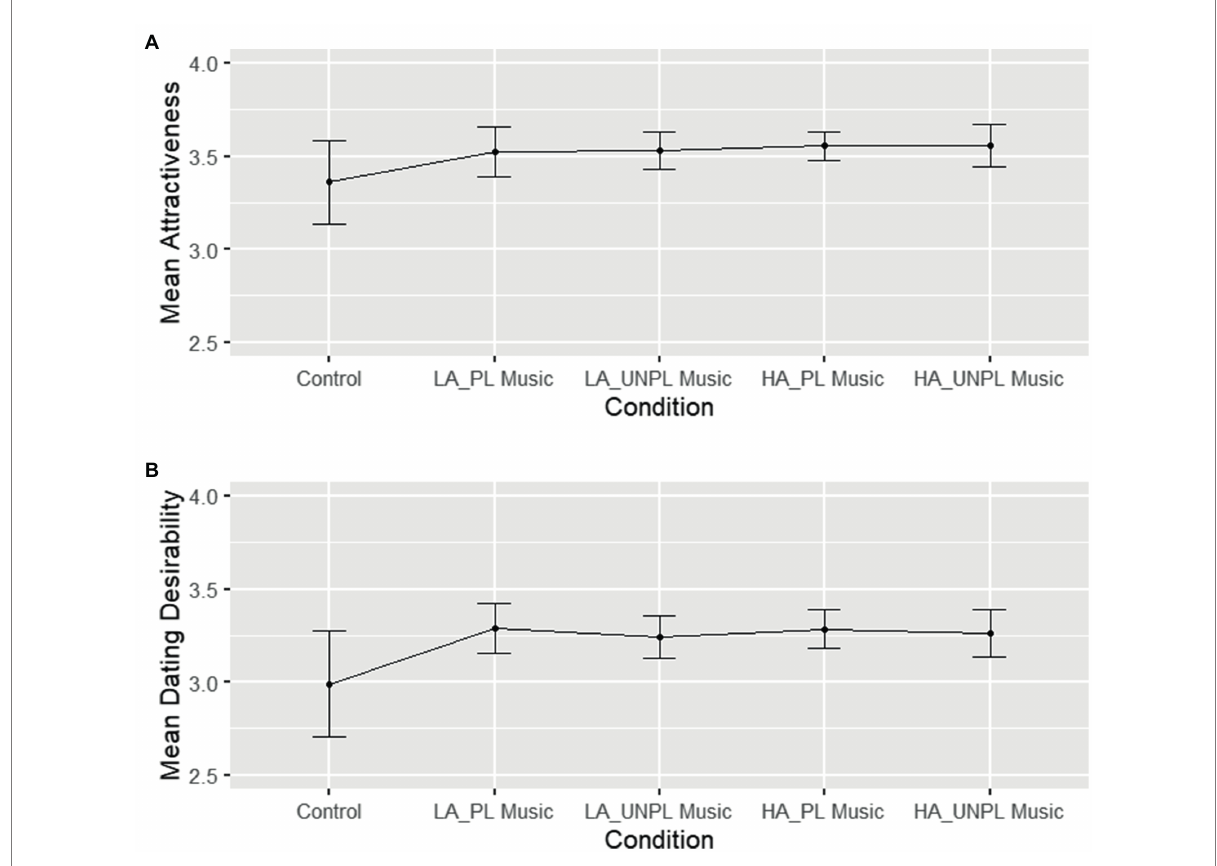
FIGURE 1 Females’ average facial attractiveness ratings of males given for each experimental condition. (A) Average facial attractiveness ratings. (B) Average dating desirability ratings. Error bars represent correlation-and difference-adjusted 95% confidence intervals. LA, low-arousing; HA, high-arousing; PL, pleasant; UNPL, unpleasant. Scales range from 1 to 7, with one indicating very low attractiveness/dating